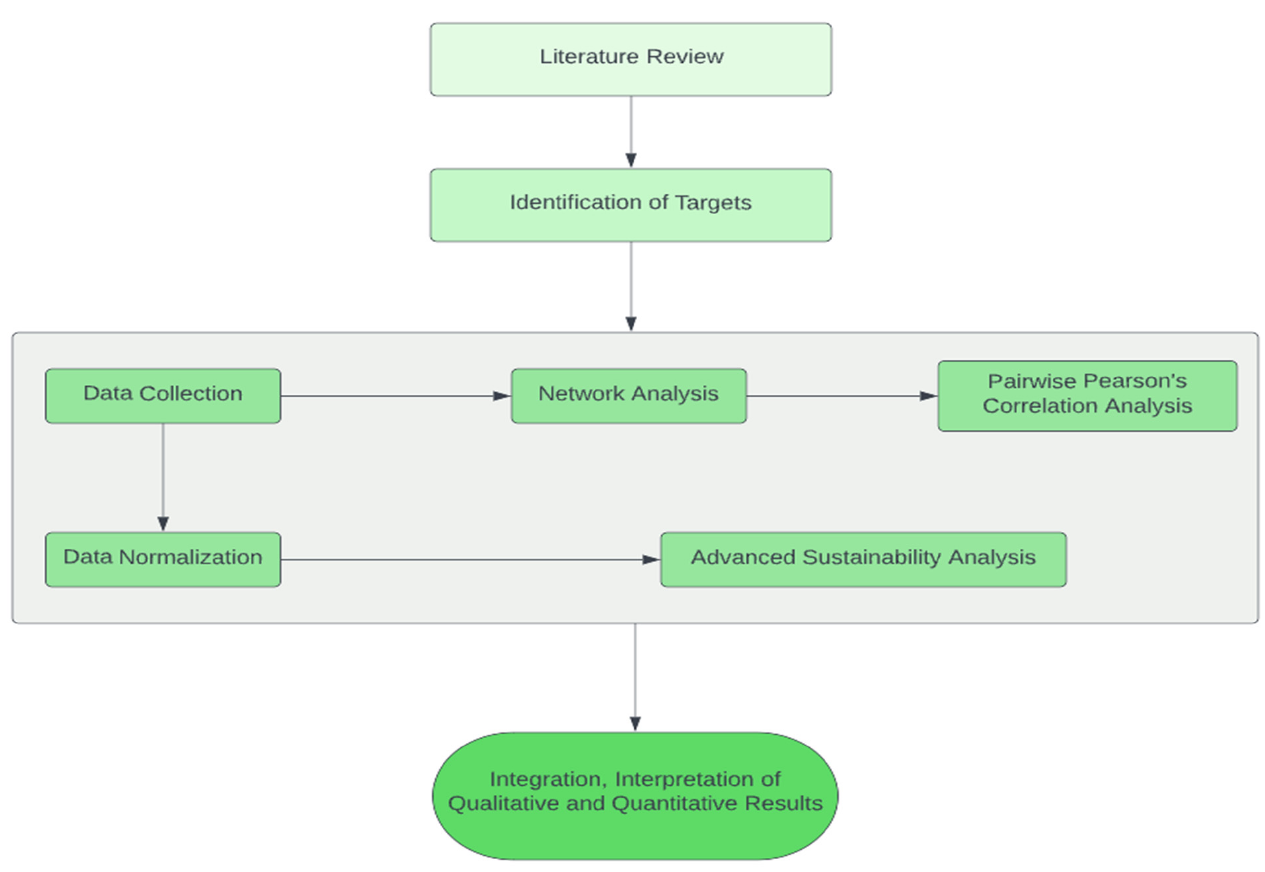
Figure 2. Analytical framework for evaluating synergy and trade-off among SDGs.